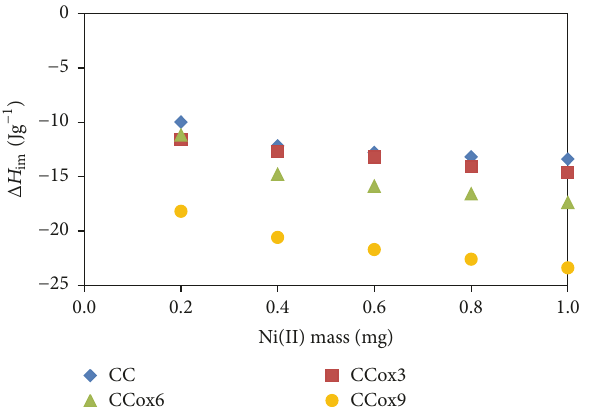
Figure 5: Ion Ni(II) differential enthalpy change in function of their mass fraction in the